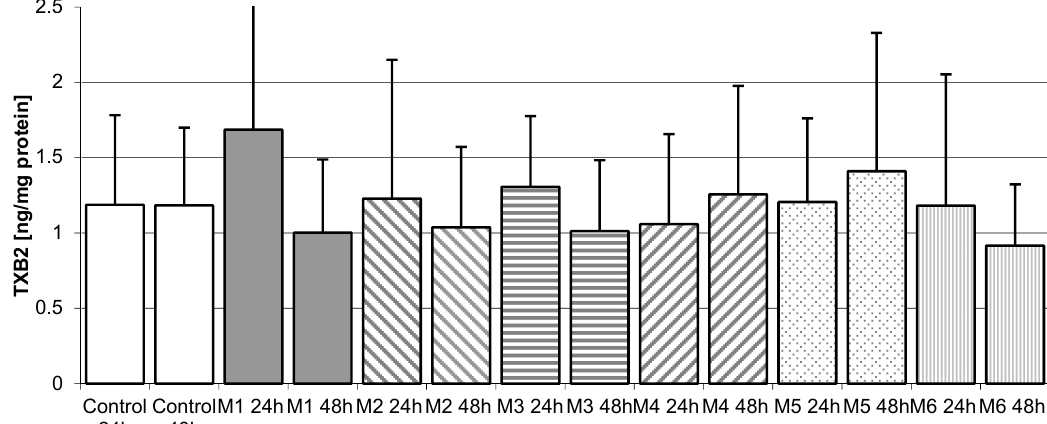
Figure 4. The levels of thromboxane TXB 2 in THP-1 monocytes cultured with various plates and dedicated screws used for surgical treatment of condylar fractures. THP-1 cells were cultured for 24 h and 48 h in RPMI medium with 10% FBS with various plates and dedicated screws: ( A ) SYNTES (S1, S2, S3); ( B ) MARTIN (C1, C2, C3, C4); ( C ) MEDARTIS (M1, M2, M3, M4, M5, M6); for details see Table 1. After incubation cells were harvested by scraping and TXB 2 concentration was measured by ELISA method. Experiments were conducted as six separate assays, each assay in three replicates, ( n = 18). * Statistically significant differences in comparison to control 24 h ( p ≤ 0.05), # Statistically significant differences in comparison to control 48 h ( p ≤ 0.05), & Statistically significant differences in comparison to appropriate plate 24 h ( p ≤ 0.05). Control cells were incubated in RPMI medium with 10% FBS.